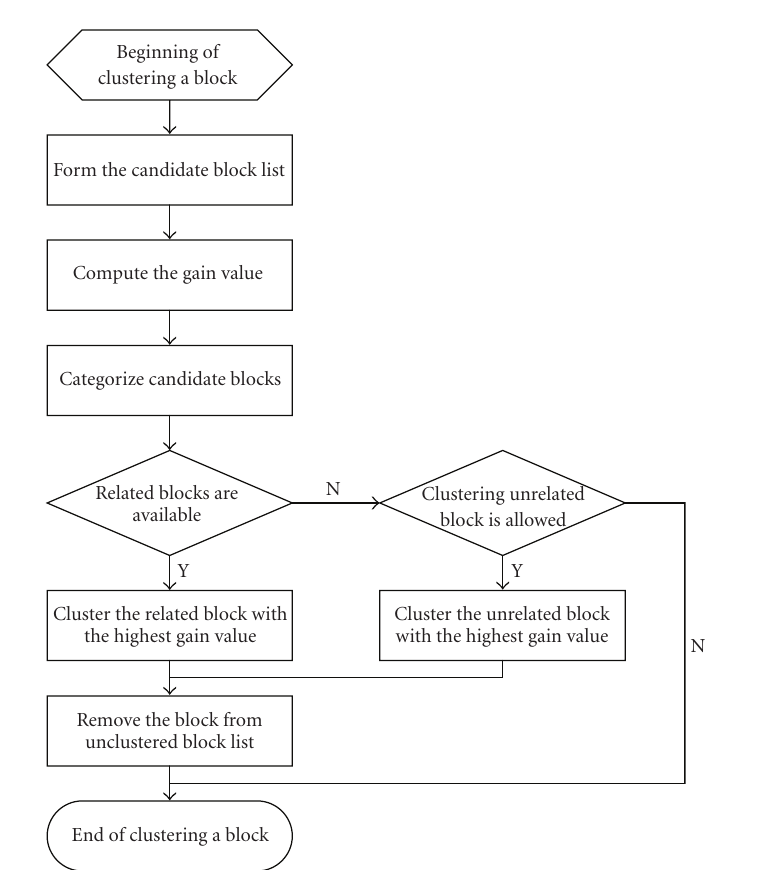
Figure 2: Algorithm flow for clustering a candidate basic logic element (BLE) into configurable logic block